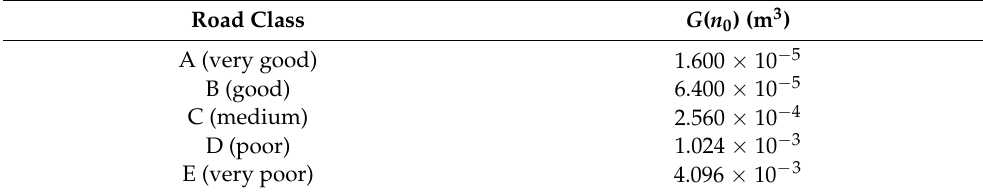
Table 8. Road roughness classification. Road